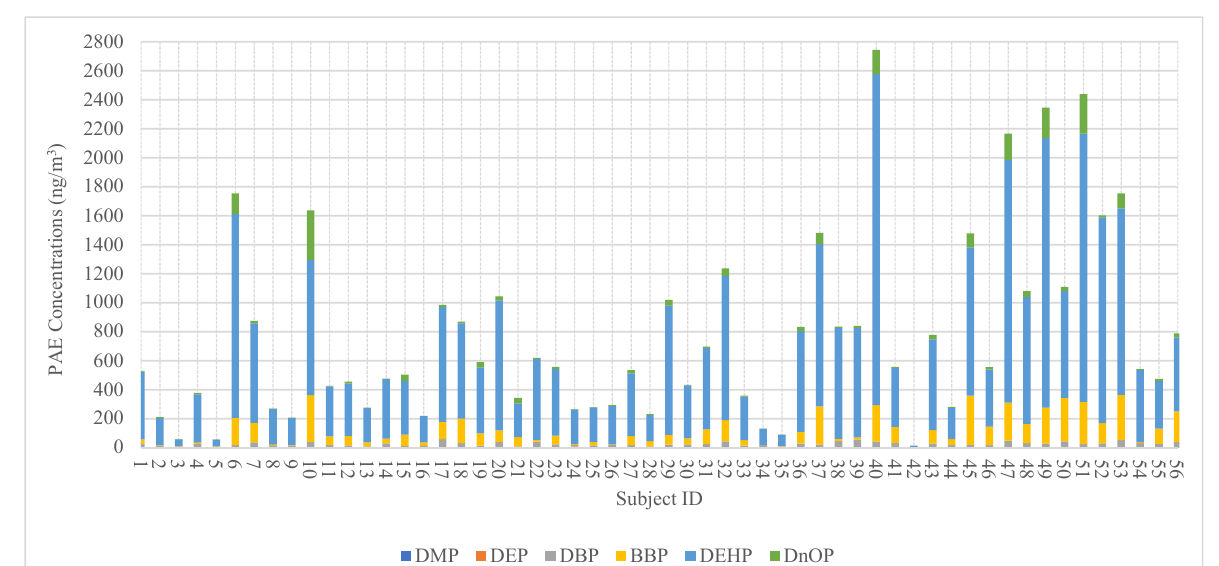
Figure 2. The ∑ 6 PAEs (the sum of six PAE congeners, including DMP, DEP, DnBP, BBP, DEHP, and DnOP) concentrations and PAE congener profiles (ng/m 3 ) that quantified in personal PM 2.5 in individual participants.